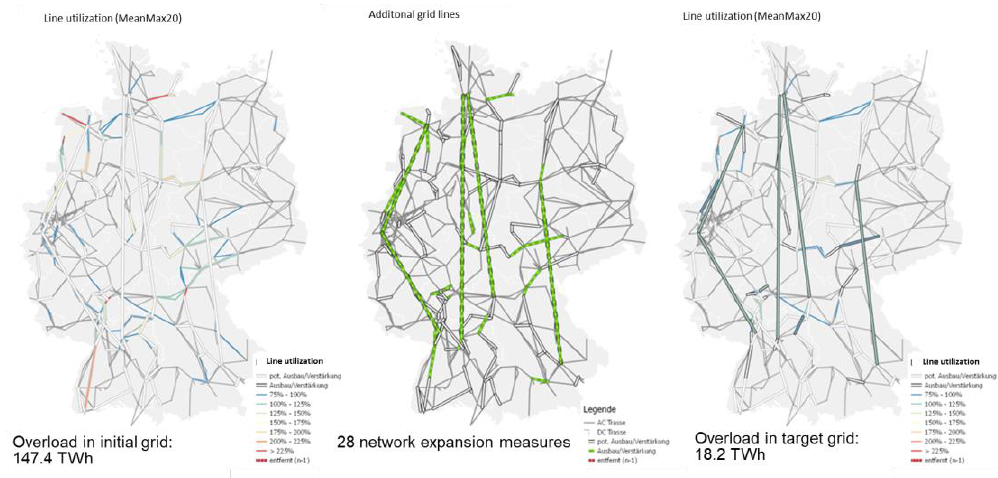
Figure 4. Results of iterative grid expansion for economic distribution scenario “NEP B 2030”.